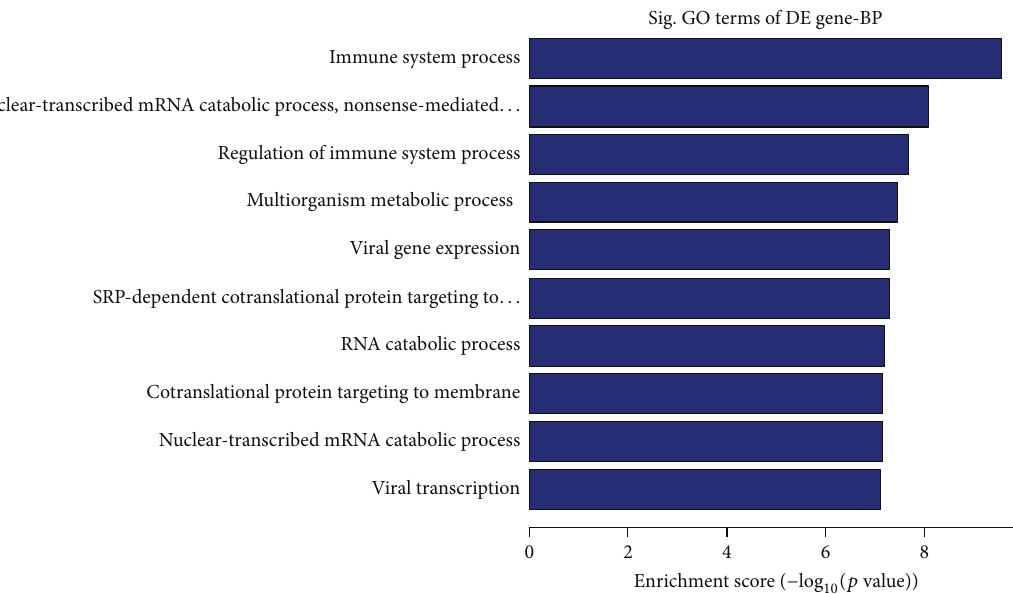
Figure 5: Enrichment scores of genes differentially expressed between bone marrow and skin mesenchymal stem cells determined by gene ontology